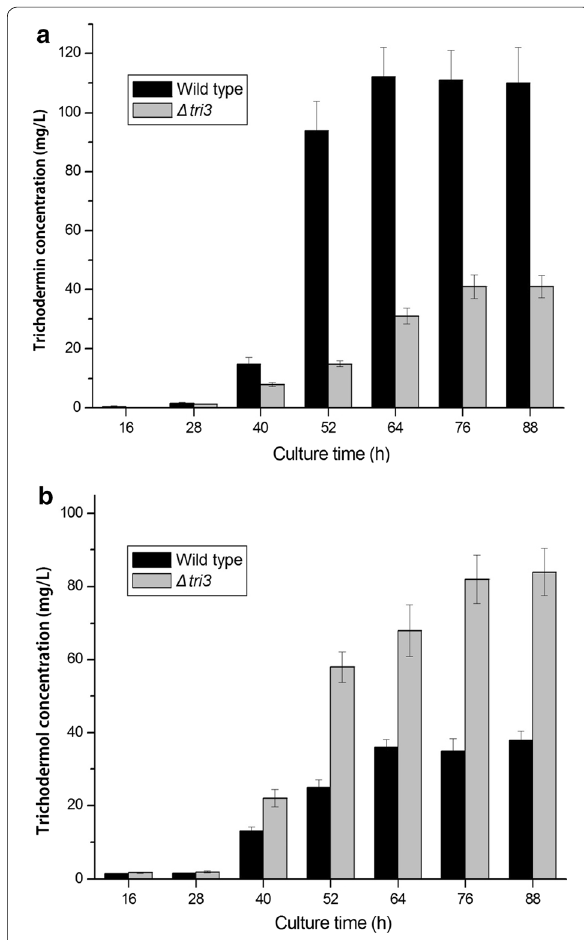
Fig. 6 a Trichodermin production by Δtri3 mutants and wild strain 0248. b Trichodermol production by Δtri3 mutants and wild strain